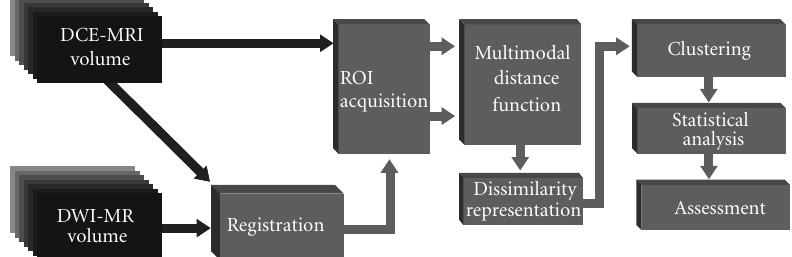
Figure 1: Perfusion/di ff usion analysis and integration